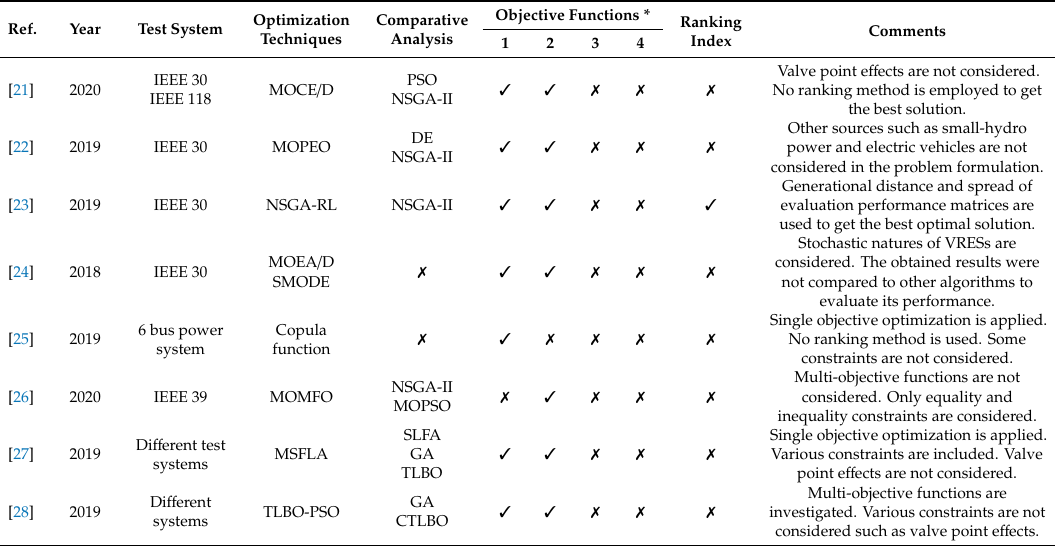
Table 2. Summary of MOEED of thermal plants integrated with VRESs. Ref. Comparative Analysis